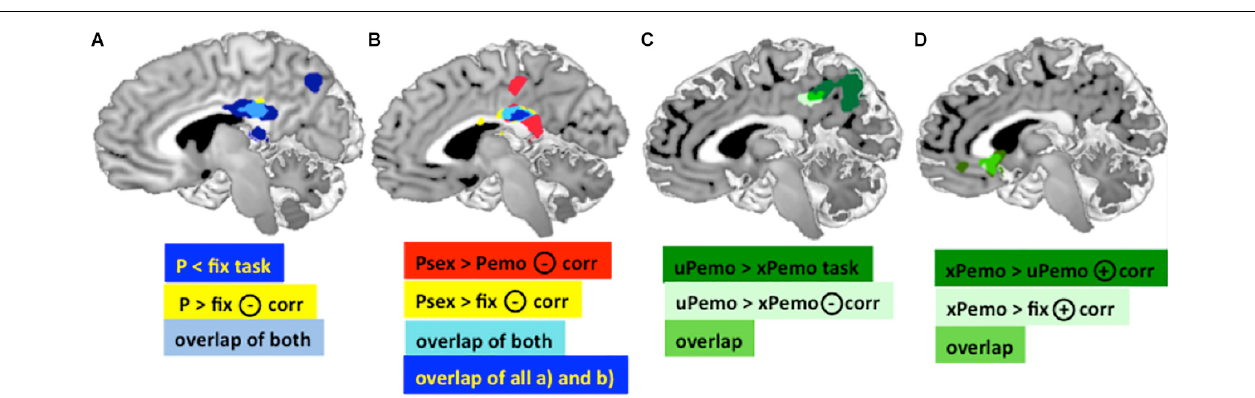
FIGURE 2 | (A) Dark blue: Main effect of task in the PCC for contrast P < fix. Yellow: Negative correlation between the BOLD response for contrast P > fix in the PCC and Glu/tCr in the dACC. Light blue: Overlap of the PCC clusters, MNI [3 –30 25]. (B) Red: BOLD response for contrast Psex > Pemo in the PCC correlates significantly negatively with the dACC Glu/tCr, MNI peak: [2 –28 26]. Yellow: BOLD response for contrast Psex > fix in the PCC correlates significantly negatively with the dACC Glu/tCr, MNI peak: [2 –28 26]. Light blue: overlap of both PCC clusters. Dark blue: overlap of both displayed PCC clusters plus the overlap cluster from (A) (light blue and yellow). (C) Dark green: Task effect in the PCC/Precuneus in contrast xPemo < uPemo, MNI peak [–14 –52 26]; Light green: Negative correlation of the Glu/tCr in dACC and BOLD response in contrast xPemo < uPemo, MNI peak [–10 –38 34]; Bright green: Overlap of both PCC clusters. (D) Overlapping VS clusters. Dark green: Positive correlation of Glu/tCr in dACC and BOLD response for xPemo > uPemo in VS and sgACC MNI peak [2 20 –2]; Light green: Positive correlation of Glu/tCr in dACC and VS BOLD mean estimates for the contrast xPemo > fix, MNI peak: [–2 24 0]; Bright green: overlap of both clusters (note: the light green cluster largely overlaps with the bright green thus is mainly represented in bright green). All pictures are displayed using Mango Software (Lancaster et al.; www.ric.uthscsa.edu/mango), p < 0.05 FWE, cluster level corrected, with initial threshold p < 0.001 n = 27.